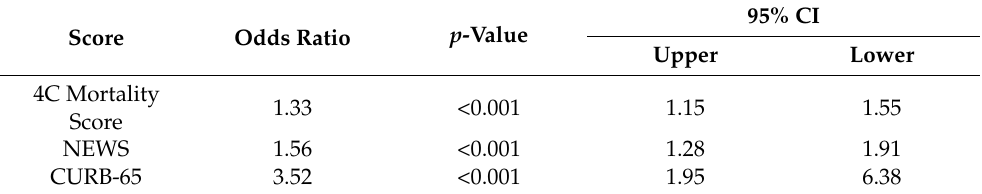
Table 5. Univariate logistic regression analysis of mortality risk scores.